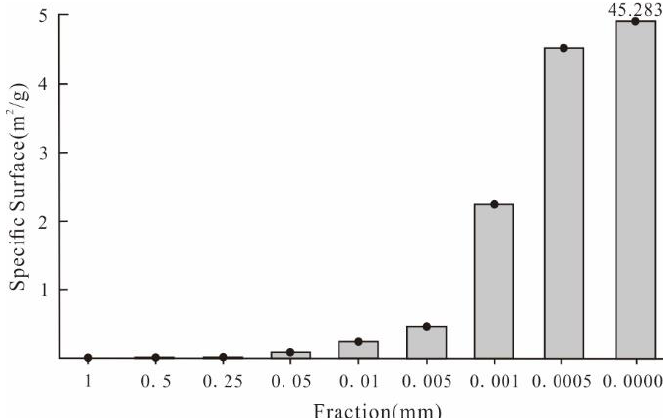
Figure 13. Specific surface of different grain size fractions in soil [44].